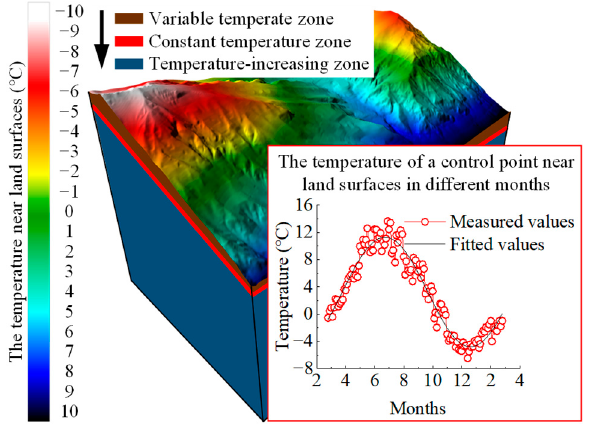
Figure 1. The vertical distribution of the temperature zone of rock masses.